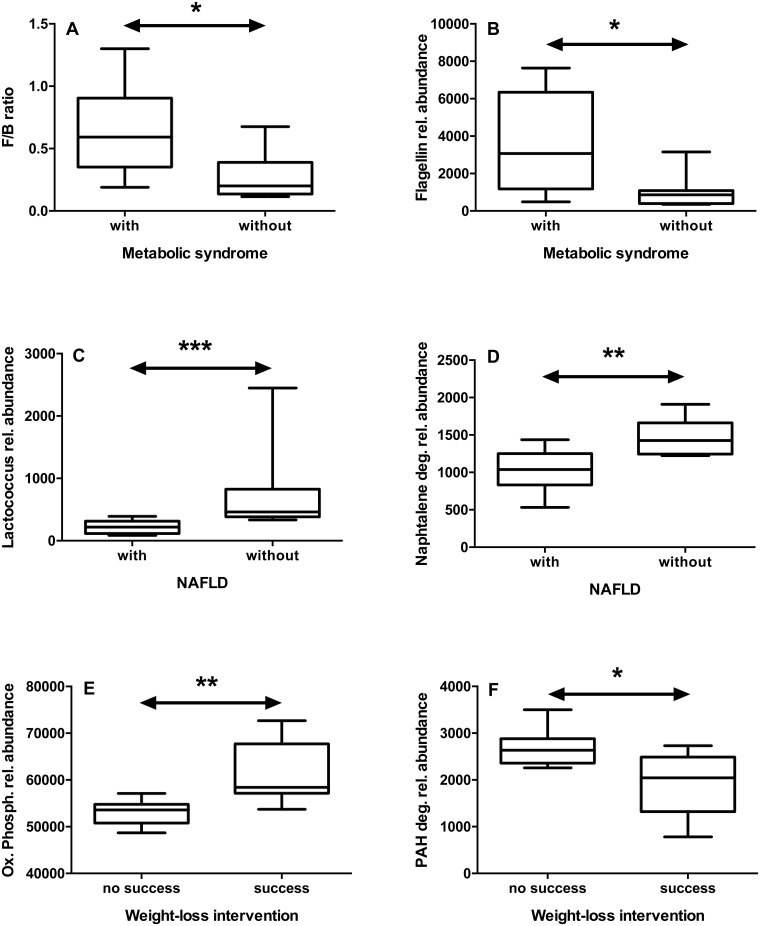
Differences in gut microbiota between patients with different co-morbidities or different outcomes.We compared patients with or without metabolic syndrome (A, B), with or without non-alcoholic fatty liver disease (NAFLD, panels C, D), and with or without persistent success in weight loss (E, F). In patients with metabolic syndrome, the Firmicutes/Bacteroidetes (F/B) ratio (A) and the flagellin gene (KEGG K02406) abundance (B) were increased at T0. In patients with NAFLD, the abundance of Lactococcus (C) and “naphthalene degradation” pathway (D) were decreased at T24. In patients with persistent success in weight loss, the abundance of the “oxidative phosphorylation” pathway was increased (E), whereas the “PAH degradation” pathway was decreased (F) at T0. Statistics: *p<0.05; **p<0.01, ***p<0.001 (Mann-Whitney’s test).